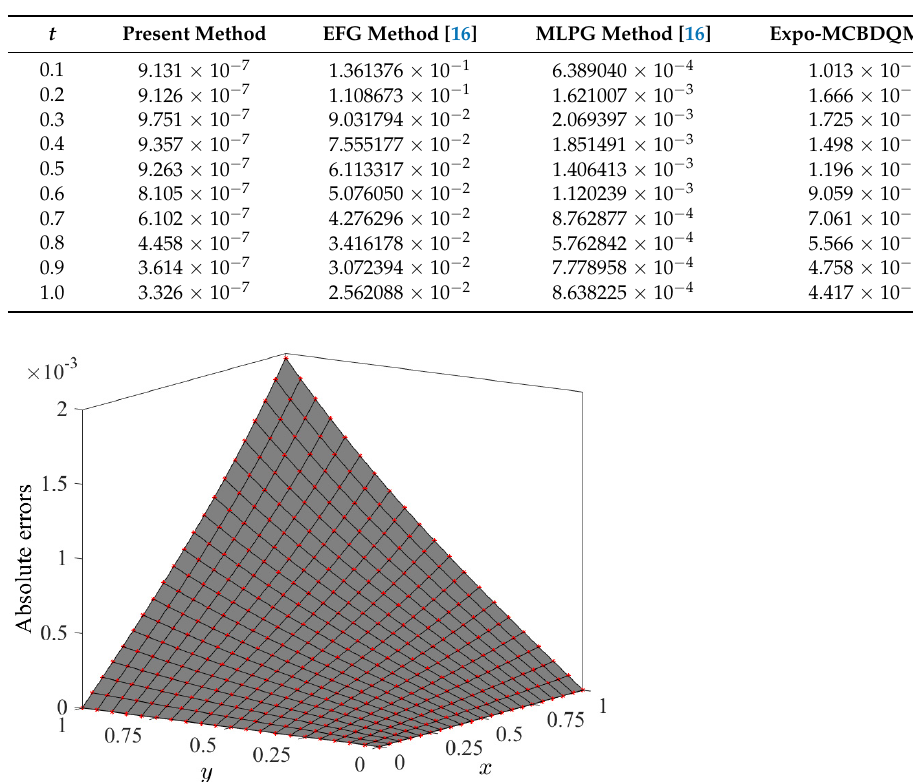
Figure 2. The absolute error norms with h = 0.05 and ∆ t = 0.01 for z = 0.5 at t = 1.